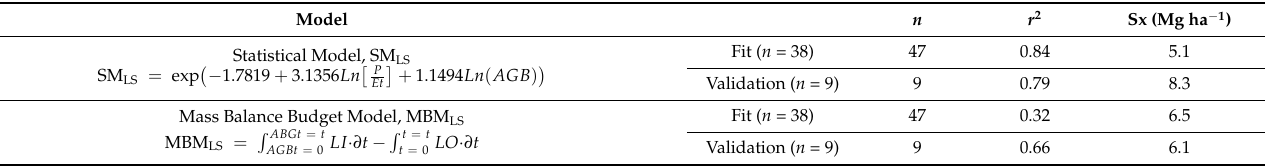
Table 3. Goodness of fit statistics for two models of predicting litter stock accumulation data in non-industrial northern Mexico’s reforestations.